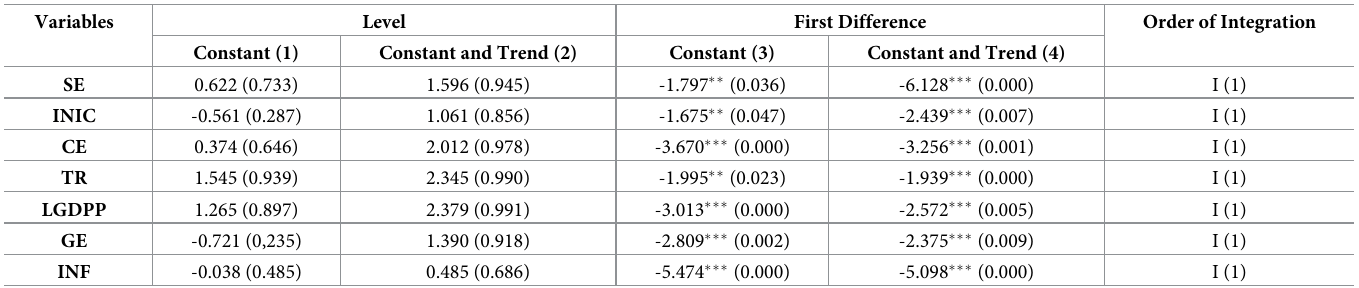
Table 5. Panel unit root test